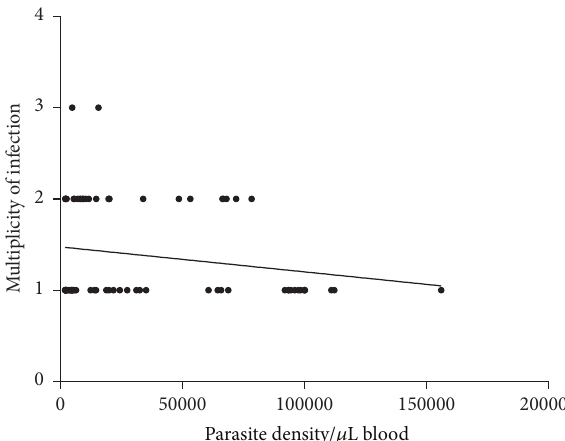
Figure 6: Relationship between multiplicity of infection and par- asite density. Spearman rank correlation test ( 𝑟 = −0.056 , CI 95% − 0.2840 to